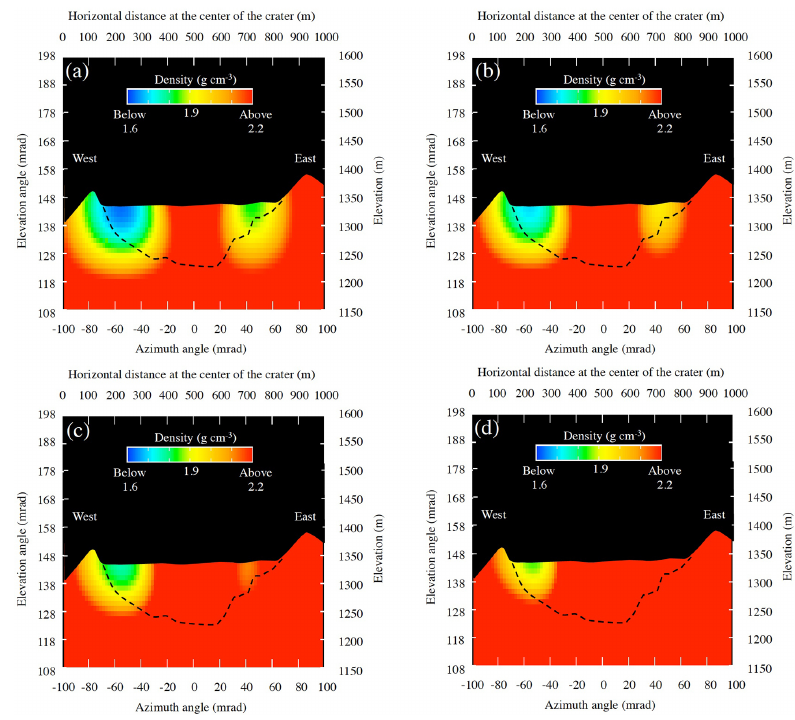
Figure 17. Interpolated muographic images showing (a) mean densities, (b) 1 σ , (c) 2 σ , and (d) 3 σ upper limit densities below the Shinmoe- dake caldera floor. The east–west cross sections of the mountain before (dotted lines) and after the 2011 eruption (February 2011) are shown. The color scale shows the average density along the muon